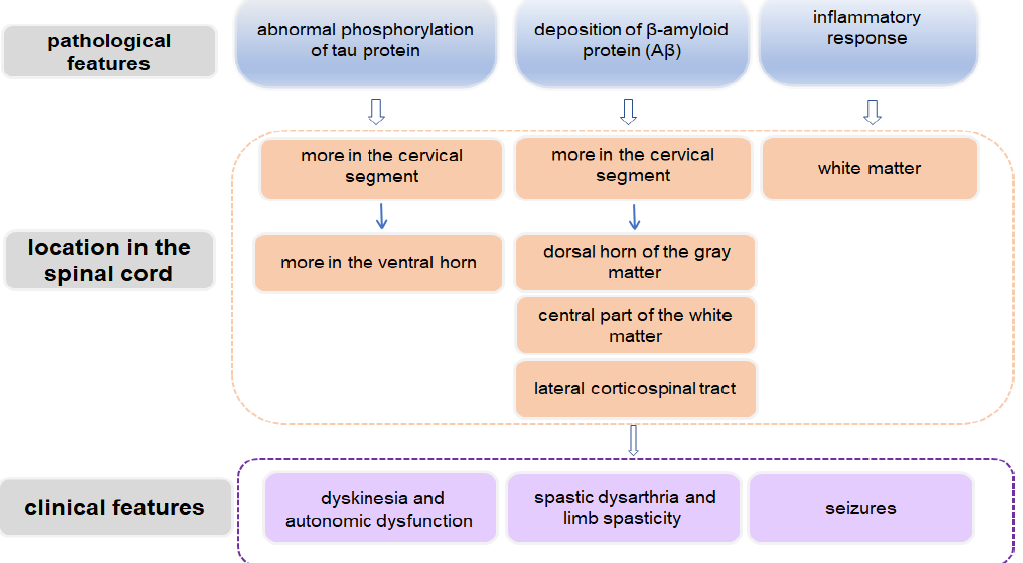
Figure 2. Schematic diagram demonstrating spinal cord-related pathological and clinical features in AD.